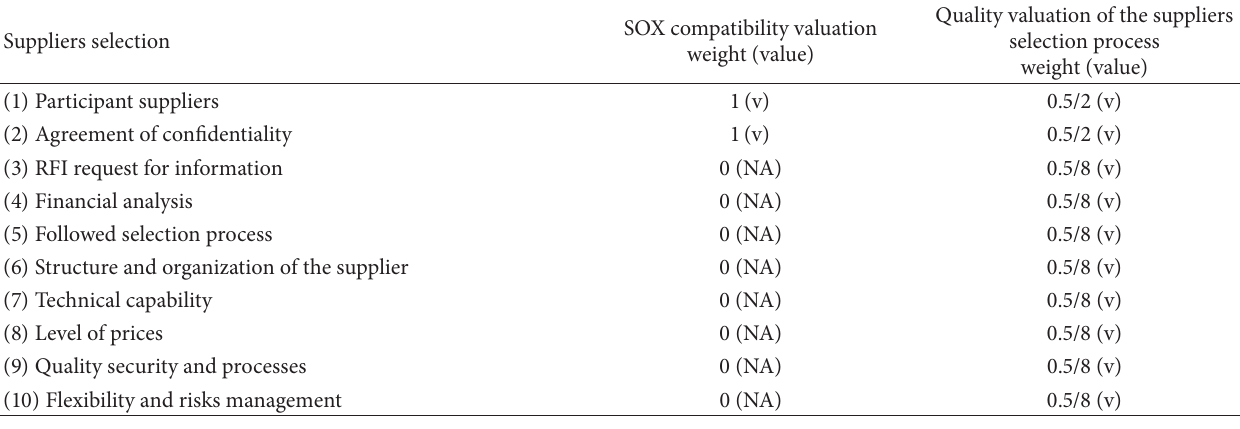
Table 13: Facts Scoring Matrix of the Suppliers Selection Process.